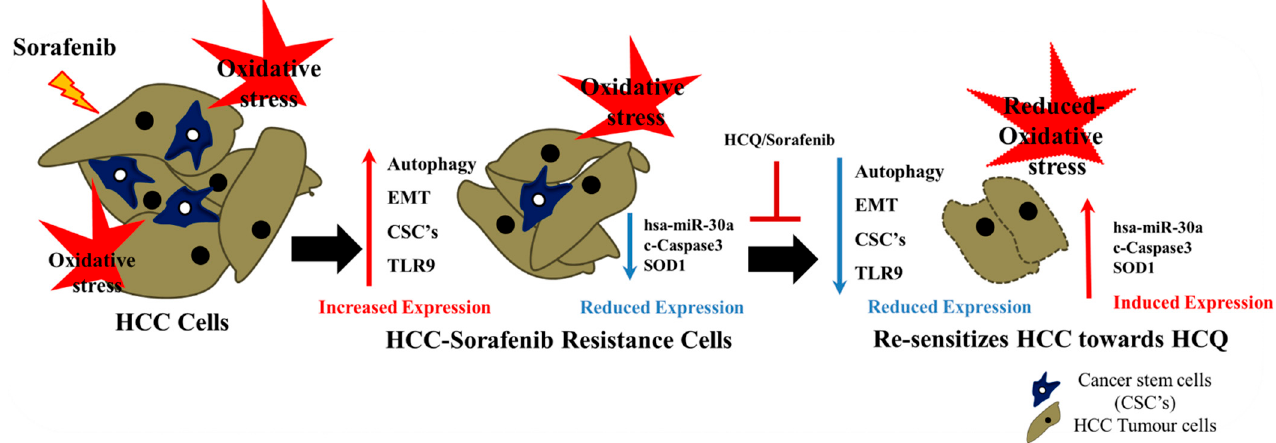
Figure 10. HCQ–sorafenib combined therapy modulated TLR9 expression, downregulated the expression of cancer stemness genes, and enhanced the antitumor efficacy of sorafenib; it did so by inducing the expression of antioxidant SOD1 enzymes and by reducing oxidative DNA damage and levels of apoptosis-associated genes in sorafenib-resistant HCC cells via the has-miR-30a-5p axis, thus maximizing the therapeutic potential for treating patients with sorafenib-resistant HCC.